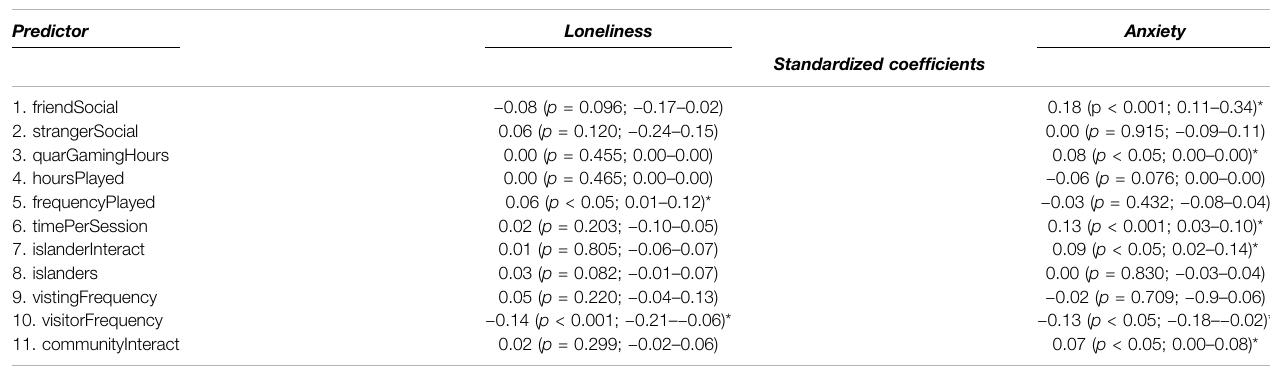
TABLE 3 | Regression coef fi cients. Predictor Loneliness Anxiety